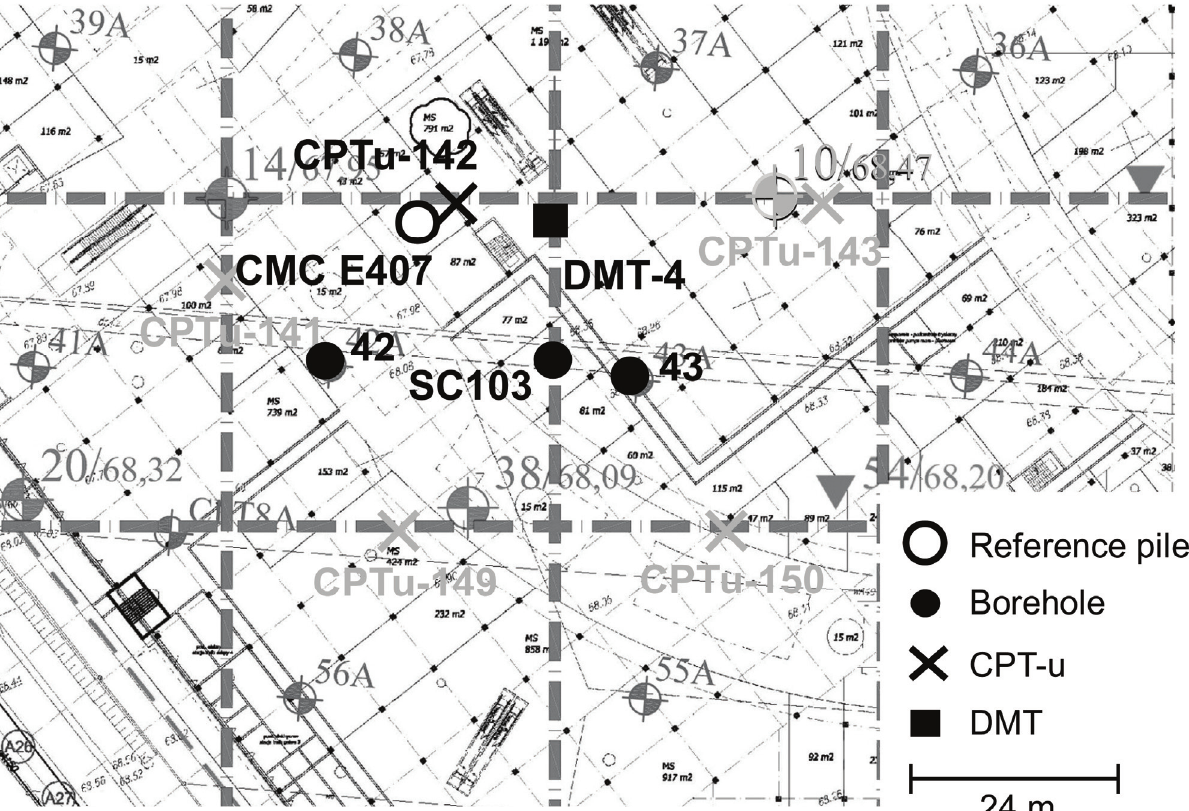
Fig. 1. Reference pile with corresponding in-situ geotechnical